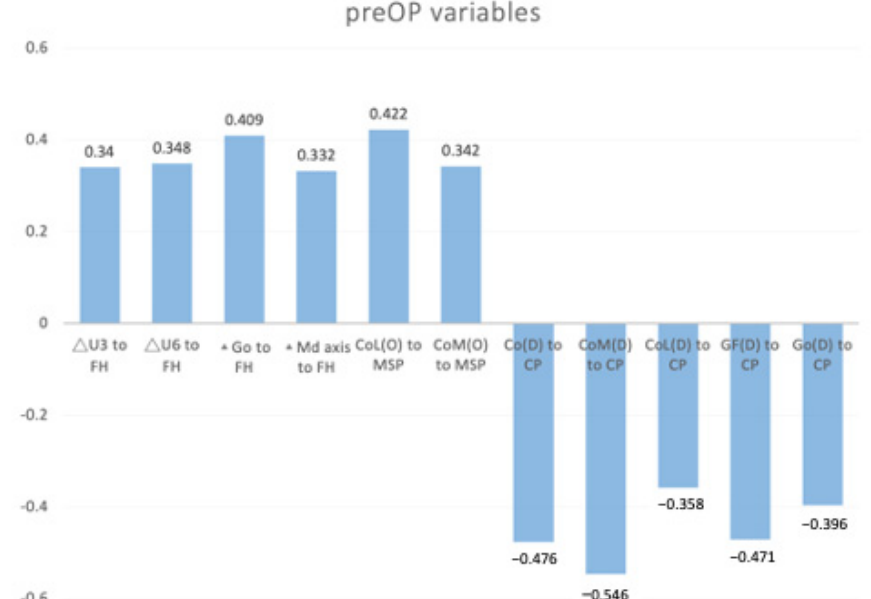
Figure 9. Significant correlation of the asymmetry index with preoperative variables. Spearman correlation was used for statistical analysis. The asymmetry index was positively correlated with the six preoperative variables and negatively correlated with five preoperative variables.